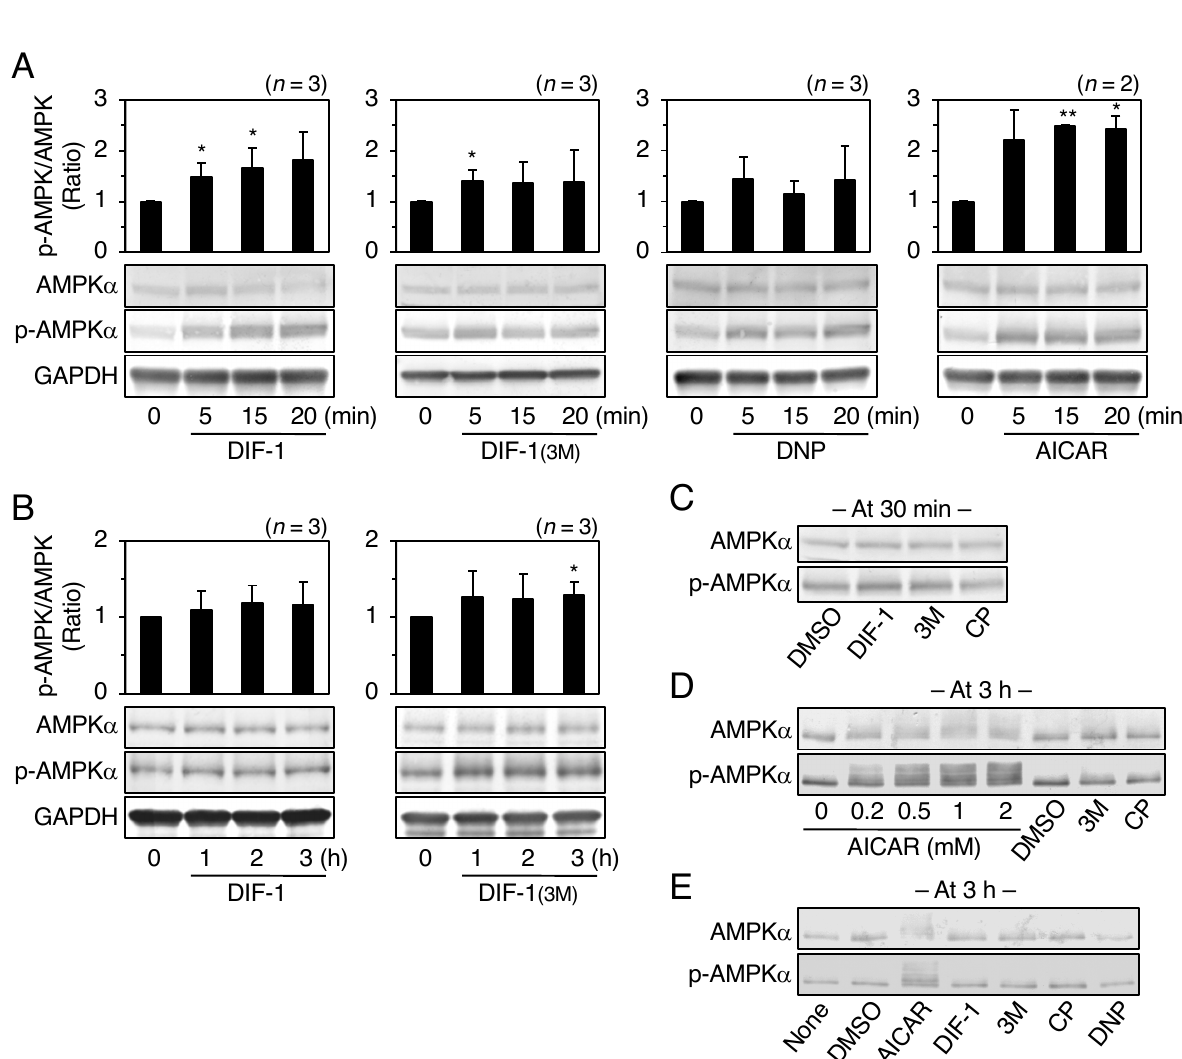
Figure 3. Effects of DIF-1 and DIF-1(3M) on AMPK phosphorylation in confluent 3T3-L1 cells. ( A , B ) Cells were incubated for the indicated times with 20 µ M DIF-1 ( A , B ), DIF-1(3M) ( A , B ), 75 µ M DNP ( A ), or 0.2 mM AICAR ( A ), and AMPK α and phospho-AMPK α (p-AMPK α ) were analyzed by Western blotting. The graphs show the ratio of p-AMPK α /AMPK α of each sample to that of the t 0 control; the mean values and SD of two or the three independent experiments are presented. * p < 0.05, ** p < 0.01 versus t 0 control. ( C ) Cells were incubated for 0.5 h with 0.2% DMSO, or 20 µ M DIF-1, DIF-1(3M) (3M), or CP-DIF-1 (CP), and AMPK α and p-AMPK α were analyzed by western blotting. ( D ) Cells were incubated for 3 h with the indicated concentrations of AICAR, 0.2% DMSO, or 20 µ M DIF-1(3M) (3M) or CP-DIF-1 (CP), and AMPK α and p-AMPK α were analyzed by western blotting. ( E ) Cells were incubated for 3 h with or without 0.2% DMSO, 2 mM AICAR, 75 µ M DNP, or 20 µ M DIF derivatives, and AMPK α and p-AMPK α were analyzed by Western